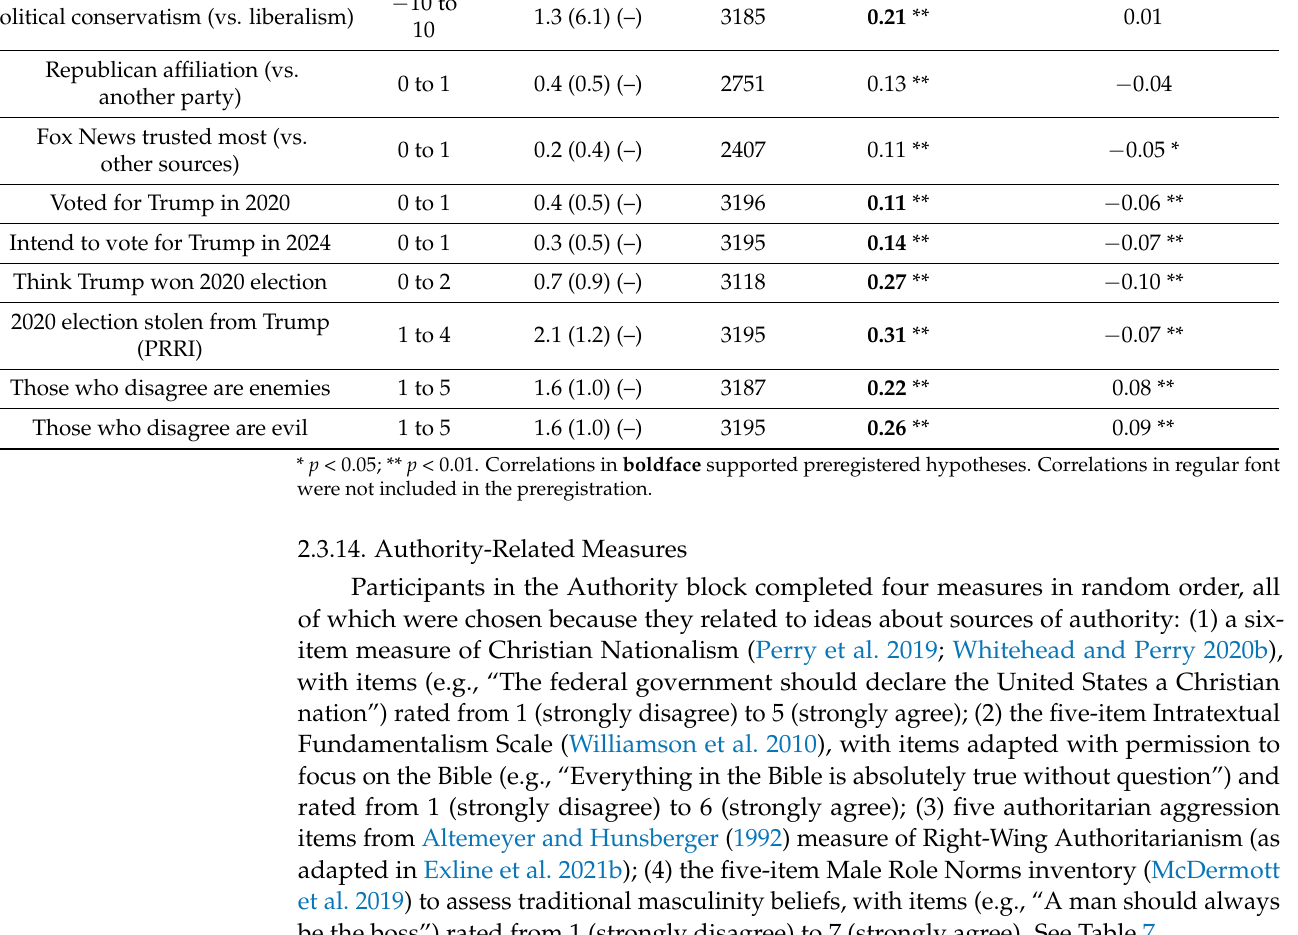
Demonic Vaccine Divine Vaccine Attributions r